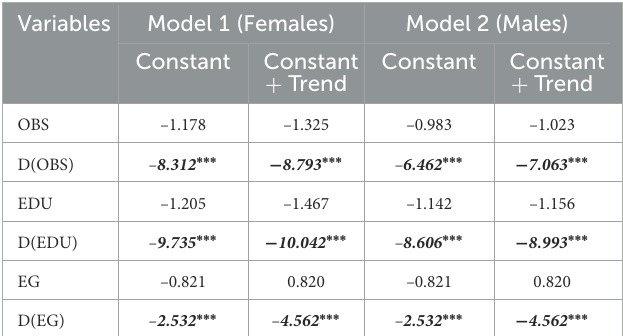
TABLE 5 CADF unit root test